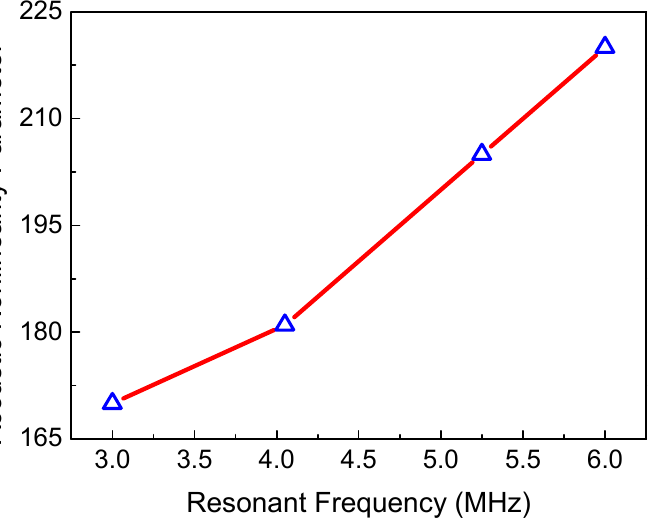
Figure 9. ANP versus the frequency of the resonant wave ( c = 0.009375, µ = 0, L 1 = 40 mm, L 2 = 4 mm, L 3 = 36 mm).